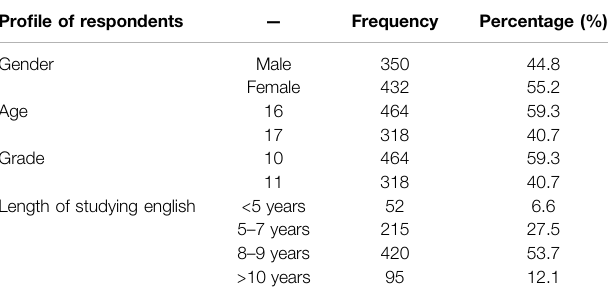
TABLE 1 | Demographic information of participants ( N =